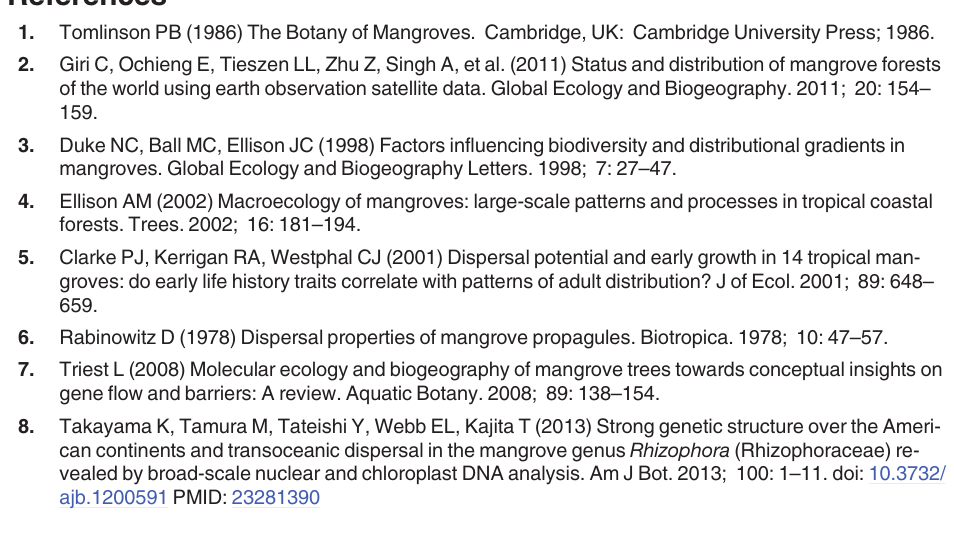
S1 Fig. Representation of Avicennia germinans multiple-geographic-scale genetic structure using STRUCTURE, considering multiple-geographic-scale genetic structure. Photographs of two geographically close environments under different tide regimes (photos by Gustavo Maruyama Mori). (PNG) S2 Fig. Representation of Avicennia schaueriana multiple-geographic-scale genetic struc- ture using STRUCTURE considering multiple-geographic-scale genetic structure. (PNG) S3 Fig. Bayesian clustering analysis of A . germinans populations sampled along the Brazil- ian coast considering inbreeding using the method implemented in InStruct [42]. (PNG) S4 Fig. Bayesian clustering analysis of A . schaueriana populations sampled along the Bra- zilian coast considering inbreeding using the method implemented in InStruct [42]. (PNG) S5 Fig. Representation of unidirectional gene flow between Avicennia schaueriana and A . germinans indicating asymmetric hybridization (photos by Gustavo Maruyama Mori).